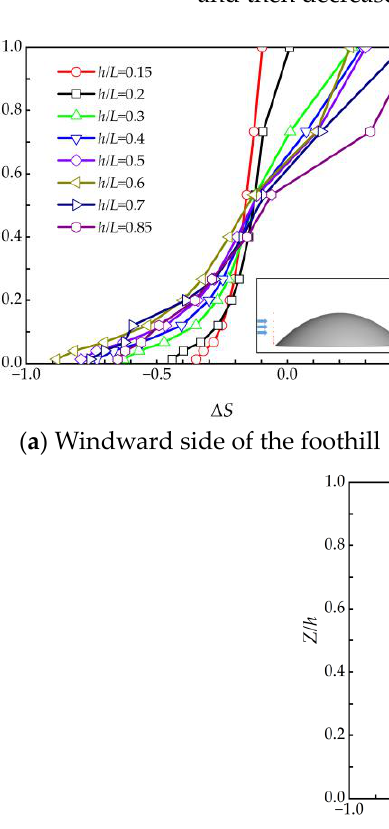
Figure 9. Change of speedup ratio with radial position ( Z/h = 0.0133).